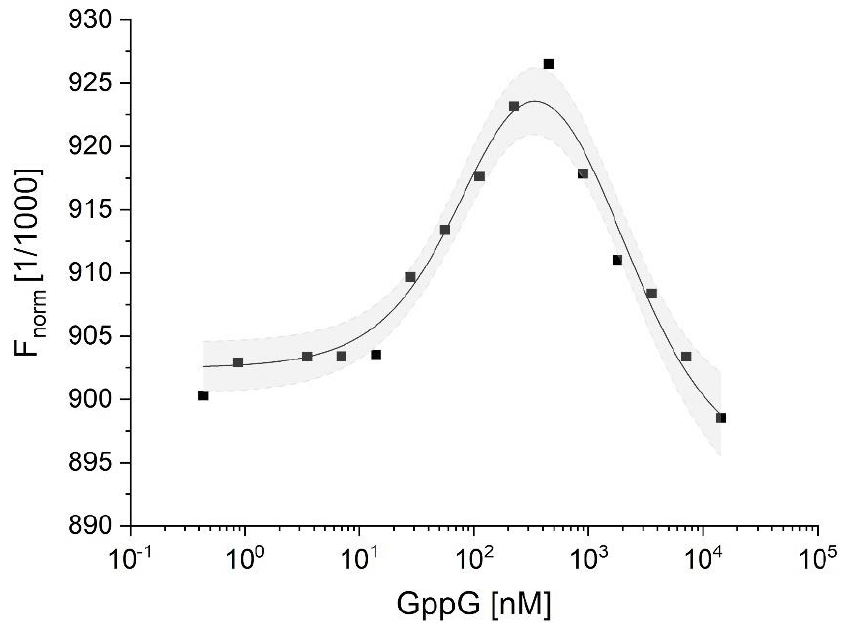
Figure 3. Representative MST pseudo-titration data for binding of GppG to hNudt16E76Q. Squares represent experimental points, solid lines represent results of fitting for two independent binding sites model, and gray area bounded by a dashed line represents 95% confidence bands for this model. See Figure S4 for other ligands data.